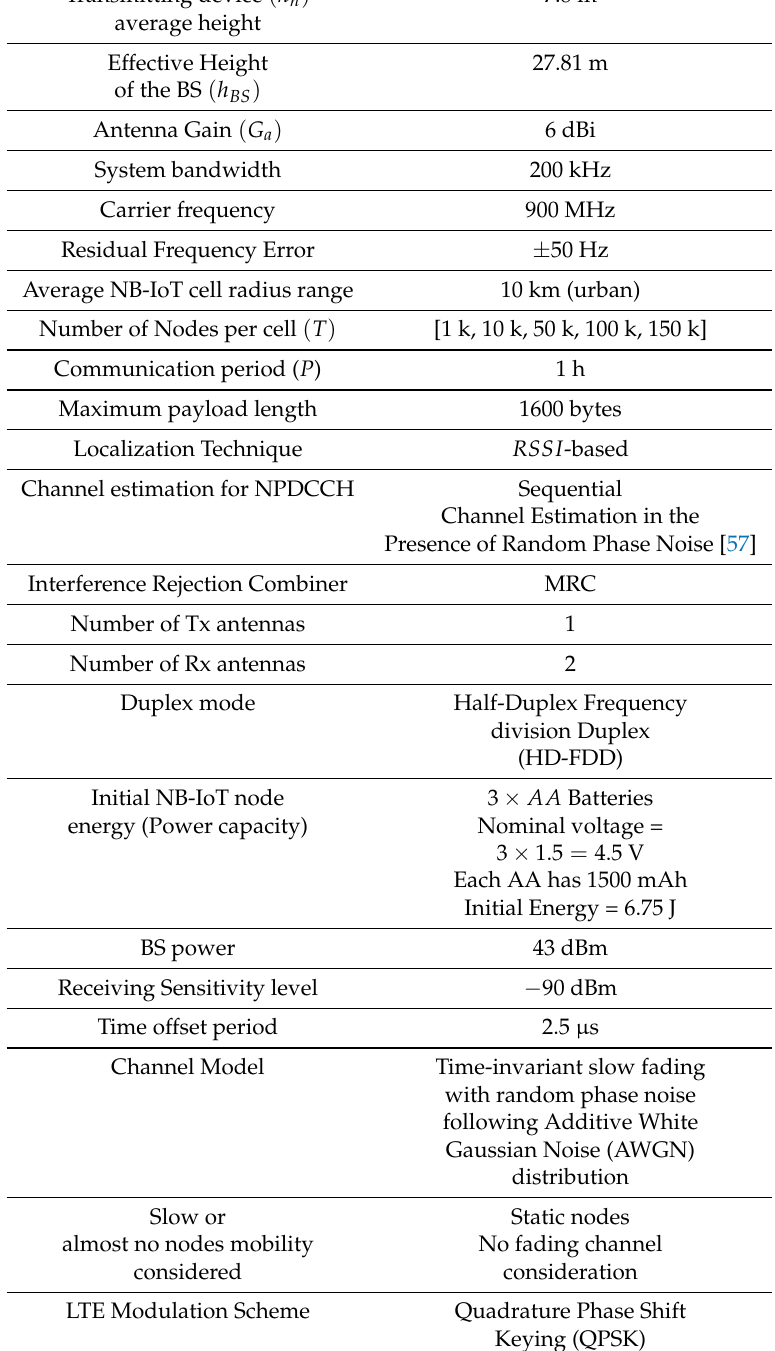
Table 1. Key simulation